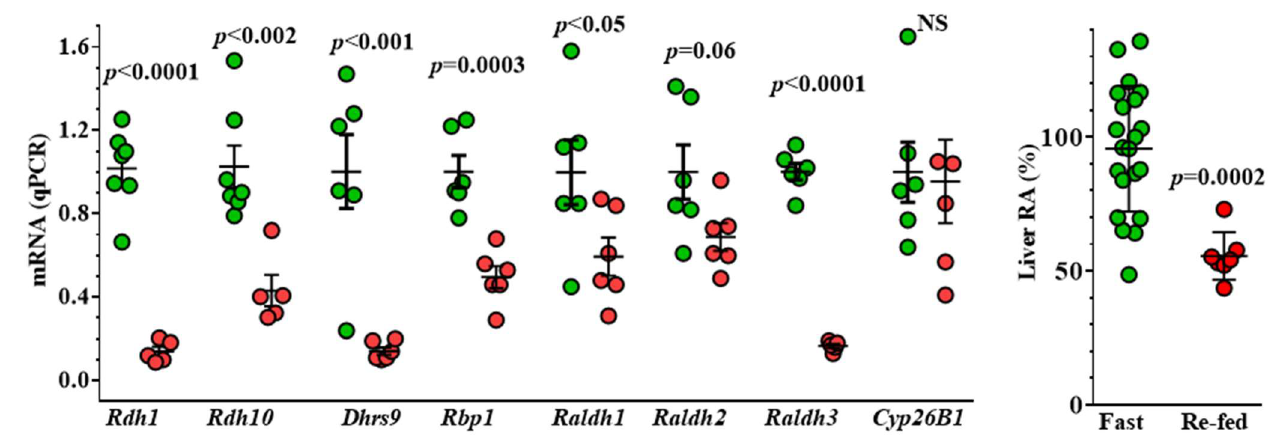
Figure 6. Regulation of retinoid metabolon mRNA and RA concentrations in liver by fasting and re-feeding. Mice were fasted for 16 h (green), or fasted for 16 h and re-fed for 6 h (red) for qPCR and re-fed for 9 h for RA quantification by LC/MS/MS. mRNA values represent data of 2–5 experiments, each with 4–8 mice per group and experiment. RA values show combined data from 3 experiments. In some experiments, re-feeding resulted in undetectable Rdh1 mRNA.